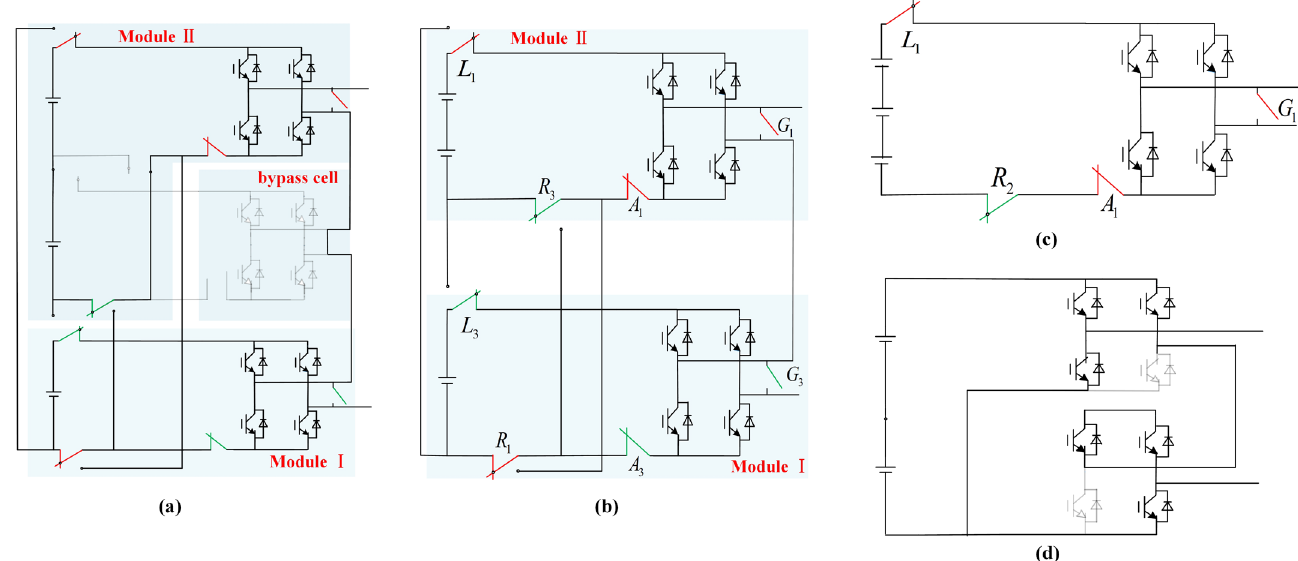
Figure 5. Transformed topology. ( a ) Transformed topology according to Mode I; ( b ) equivalent topology in ( a ); ( c ) Module III ( d ) Module IV.